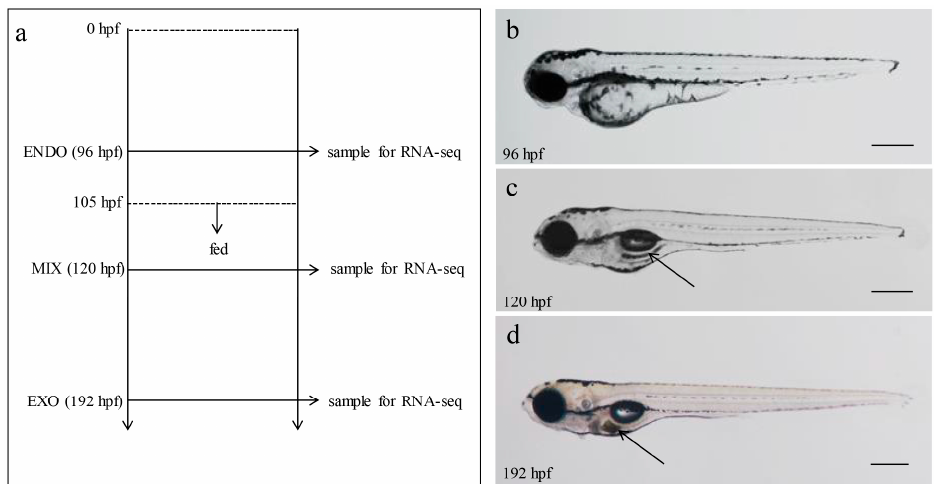
Figure 1. Samples were taken during transition from endogenous to exogenous feeding in zebrafish. ( a ) Flowchart of sampling. Zebrafish embryos were incubated at 28.5 °C from fertilization to 96 hpf, 120 hpf, and 192 hpf, respectively, and samples were taken for RNA-seq or qPCR. The time scales are shown on the left; ( b ) ENDO (96 hpf), the larvae start feeble swimming after hatching, yolk as the